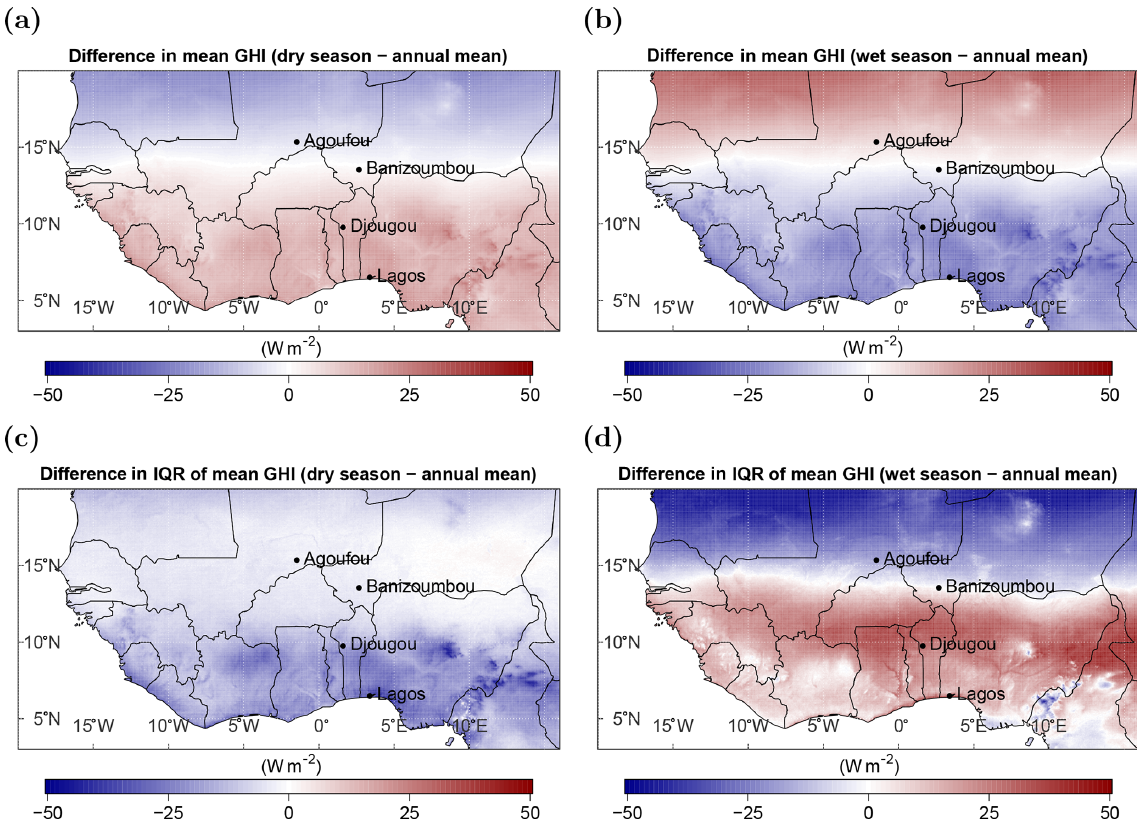
Figure 6. The difference between the mean annual GHI and the mean seasonal GHI during the dry season (a) and the wet season (b) , and the difference in their respective interquartile ranges (c, d) .